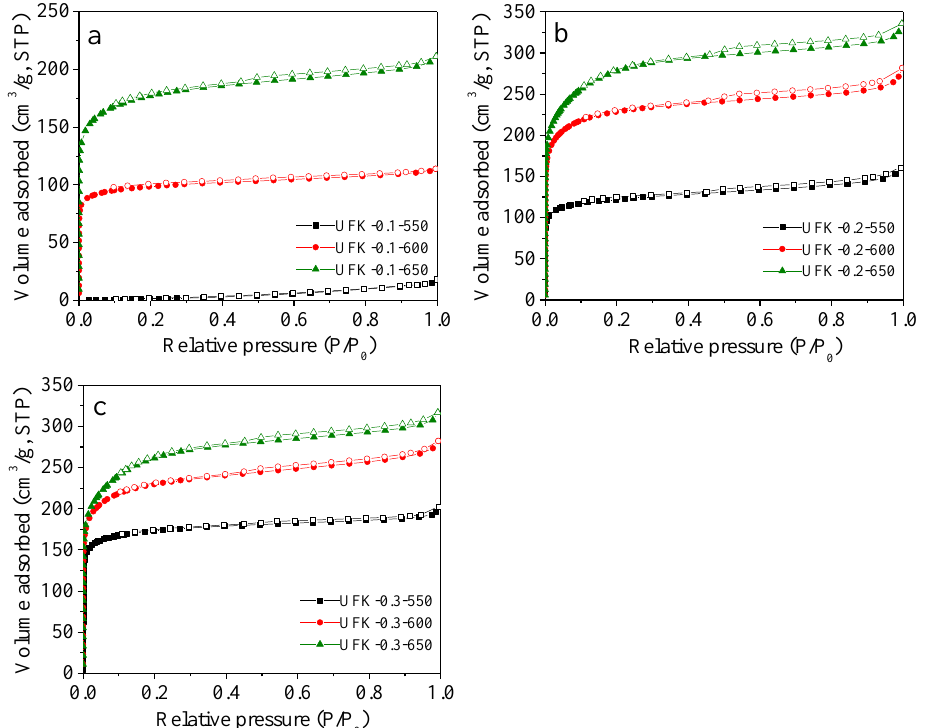
Figure 3. N 2 sorption isotherms of the samples prepared at KOH/UF mass ratio of ( a ) 0.1, ( b ) 0.2 and ( c ) 0.3. Filled and empty symbols represent adsorption and desorption branches, respectively.